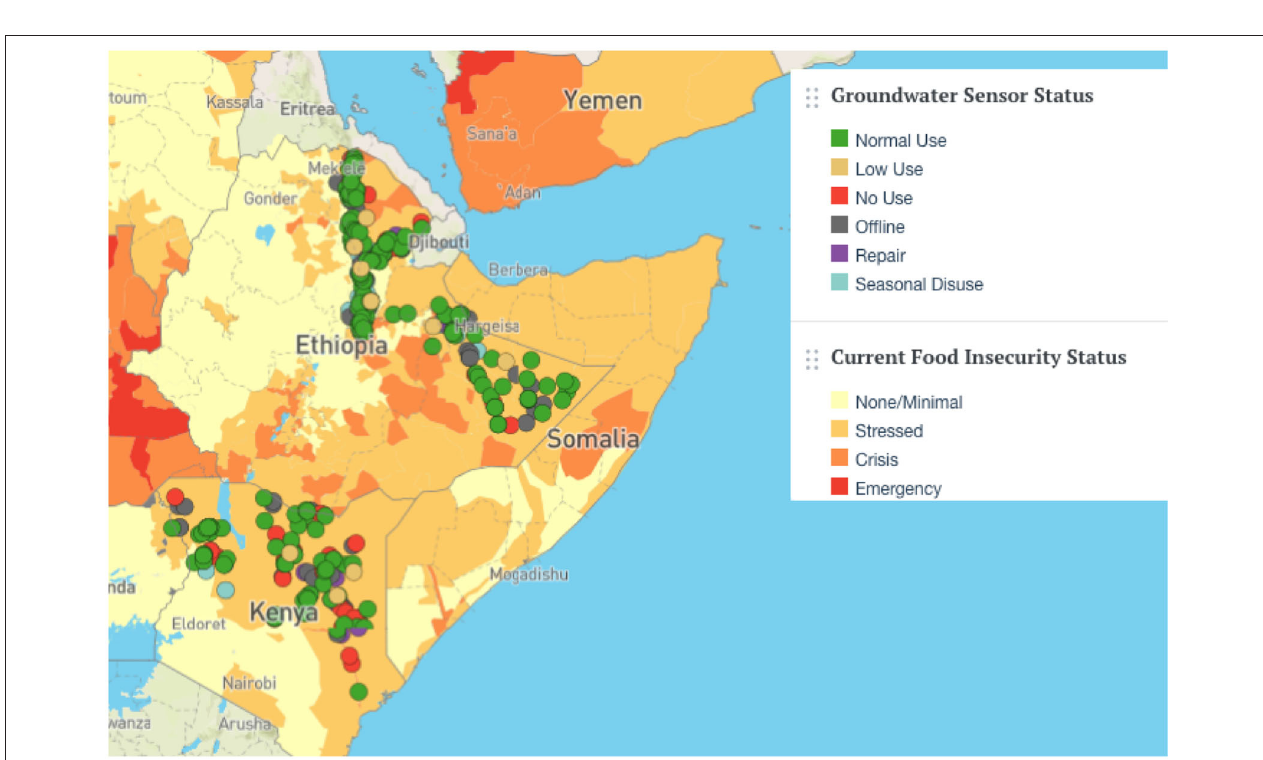
FIGURE 3 | DRIP borehole status map with Famine Early Warning System (FEWS NET) food security classification in March, 2020. Available through https://prepdata. org/dashboards/the-drought-resilience-impact-platform-drip.